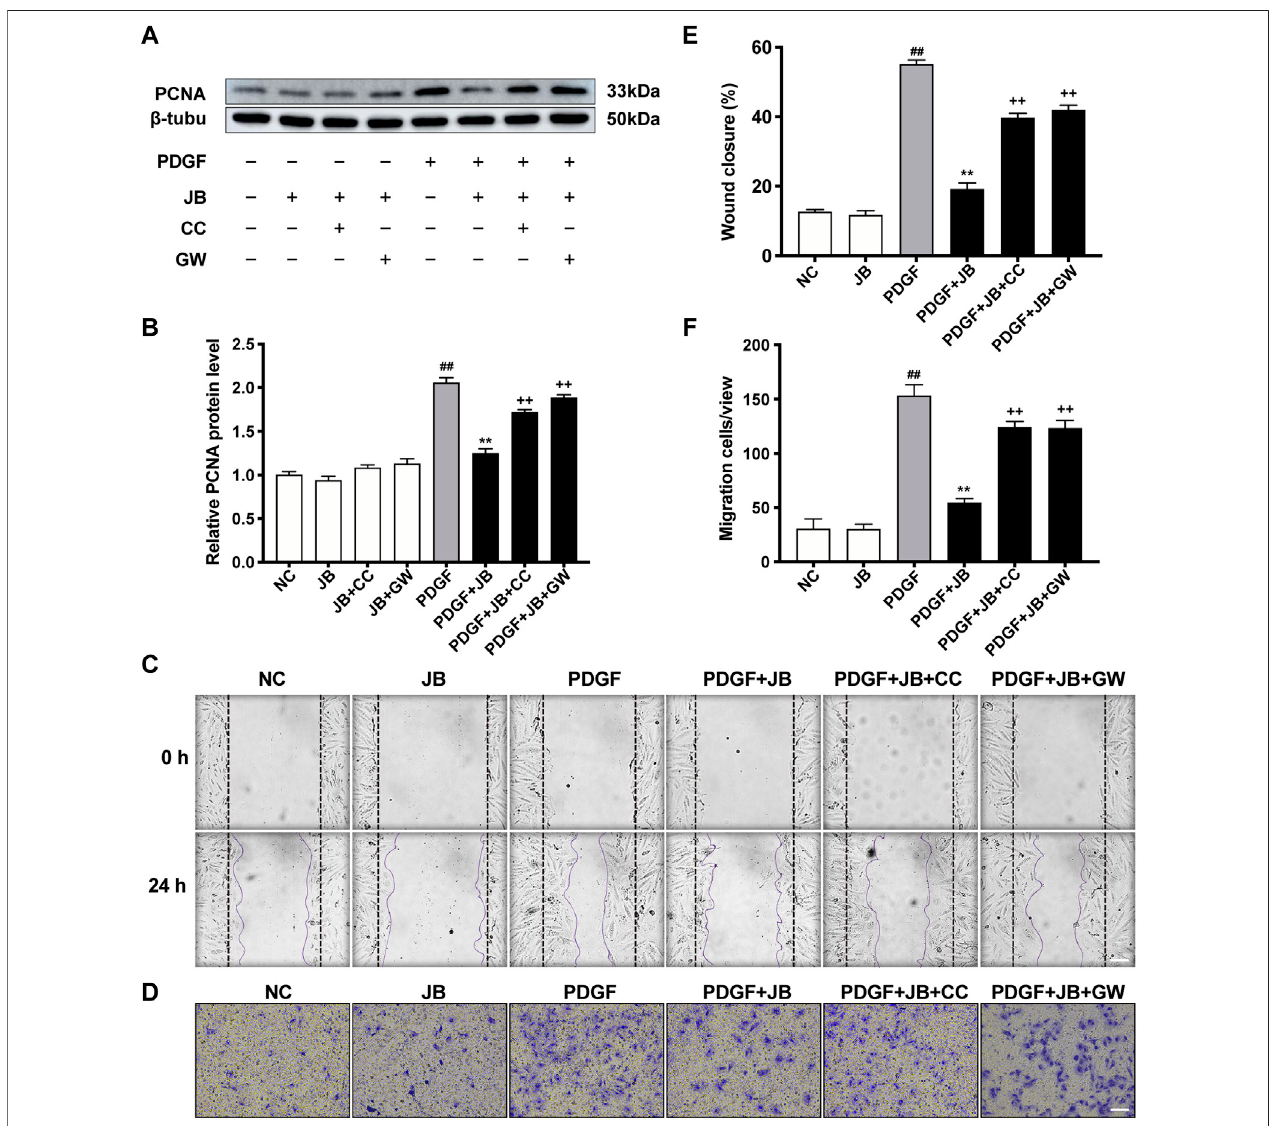
FIGURE 8 | JB inhibited VSMCs proliferation and migration through AMPK/PPAR- γ pathway. VSMCs was incubated with CC or GW for 2 h and then treated with JB. (A,B) Western blotting analysis of PCNA in VSMCs (A) and corresponding protein level quanti fi cation (B) . (C,E) Representative images of cell migration by wound healing test (C) and quanti fi cation of wound healing in each group (E) . Scale bar: 100 μ m. (D,F) Representative images of cell migration by Transwell assay (D) and quanti fi cation of VSMCs stained with crystal violet in each group (F) . Scale bar: 100 μ m. Data are expressed as mean ± S.D. ## p < 0.01 vs. Control. ** p < 0.01 vs. PDGF-BB group. ++ p < 0.01 vs. the PDGF + JB group. n (cid:1) 3.